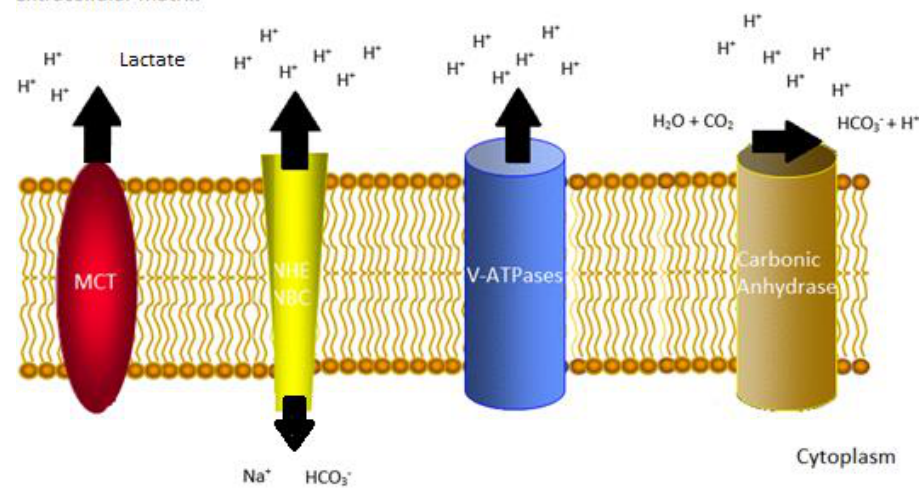
Figure 1. Schematic model of the effects of proton pump regulators on cancer cells. MCT, monocarboxylate transporter; NHE, N + / H + transporter; NBC, sodium bicarbonate cotransporter; V-ATPase, vacuolar ATPase.